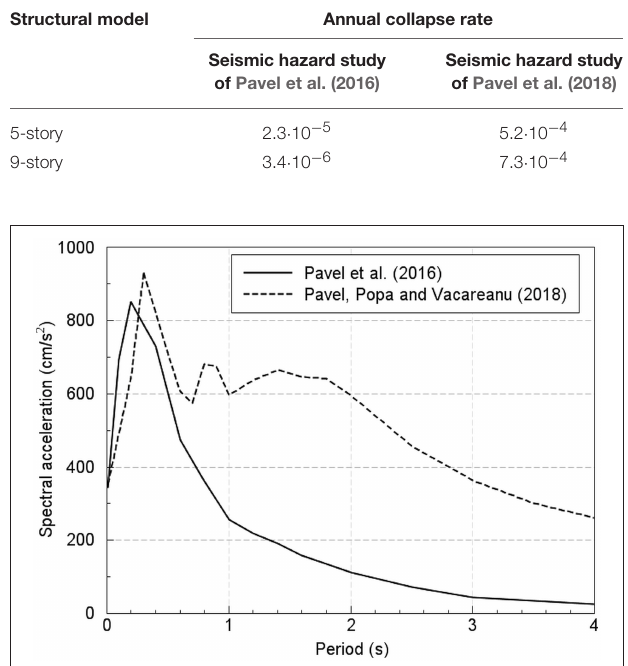
controlling the collapse rate is the fragility. In the case of the results based on the seismic hazard from Pavel et al. (2016), the decrease of the seismic hazard levels from one structure to the other is so large that the resulting collapse rate is much smaller for the nine-story model (even though, as noted before, its median collapse fragility is